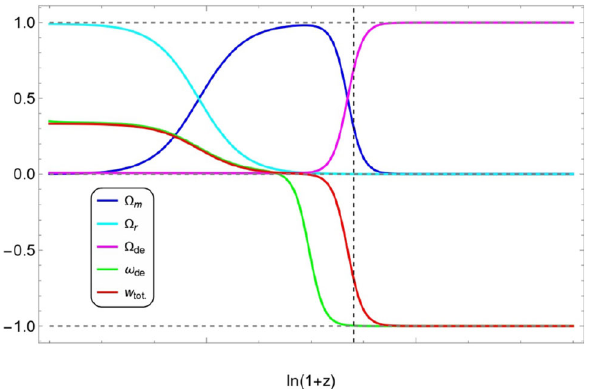
Fig. 2 The evolution of the density parameters as well as of the equation-of-state parameter, as functions of the redshift, for the case, λ = 0 . 001 with the initial condition of dynamical system variables: x = 10 − 4 , y = 10 − 6 , u = 0 . 7 × 10 − 2 , ρ = 0 . 933254, z = 10 − 4 , which are representative for their definitions in Eqs. (26,27). The verti- cal dashed line denotes the present cosmological time ( z =